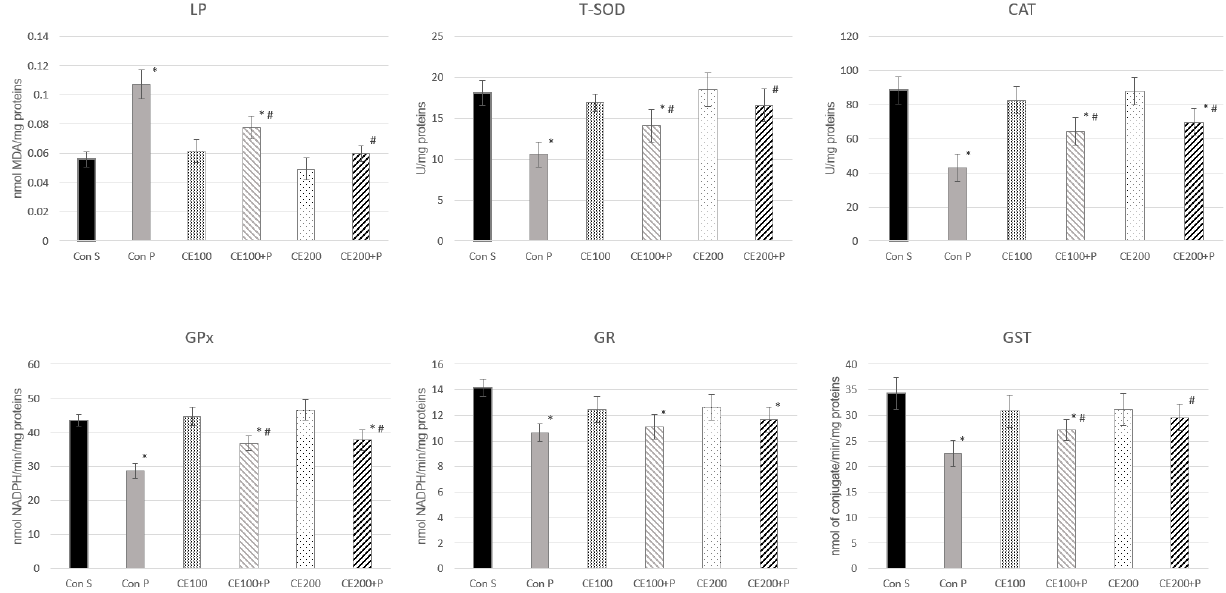
Figure 3. Effects of carob extract on paracetamol-induced oxidative stress (* p < 0.05 significantly different from ConS; # p < 0.05 significantly different from ConP).